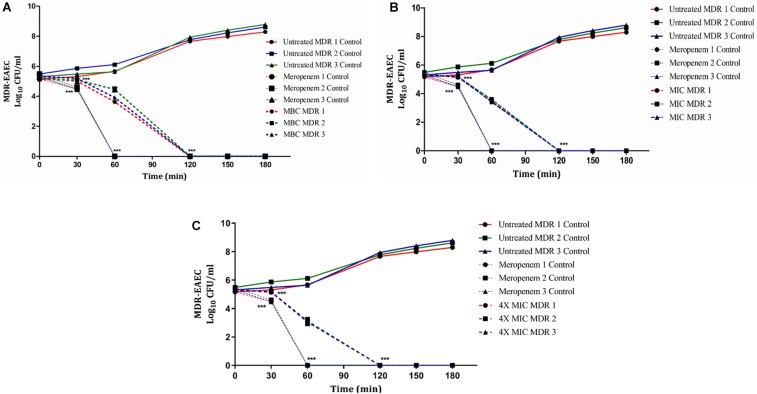
Dose- and time-dependent killing kinetics of MDR-EAEC isolates co-cultured with Indolicidin at different time intervals. Three MDR-EAEC isolates were co-cultured with: MBC of Indolicidin (A); MIC of Indolicidin (B); 4X MIC of Indolicidin (C) in CA-MH broth at 37°C under static conditions. Simultaneously, respective controls of MDR-EAEC isolates (untreated and meropenem-treated) were incubated in CA-MH broth. Data expressed as the mean ± standard deviation (log10CFU/mL) of three independent experiments. Error bars are so close to display. ∗∗∗P < 0.001.